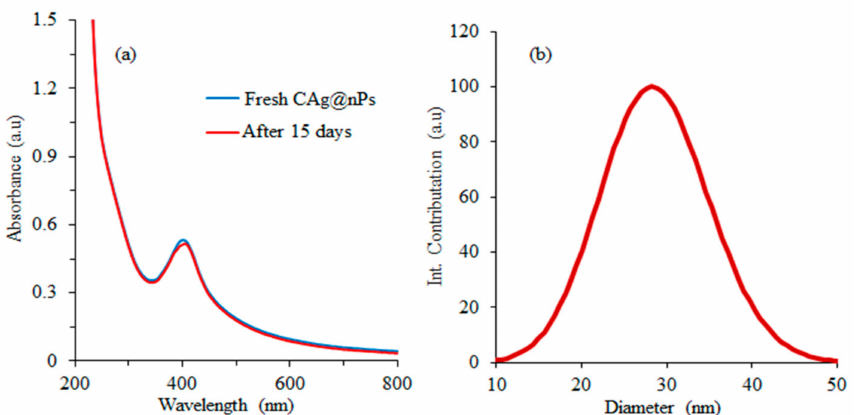
Figure 5. ( a ) Time dependent stability of biosynthesized CAg-nPs and ( b ) particle size distribution of biosynthesized CAg-nPs particles.